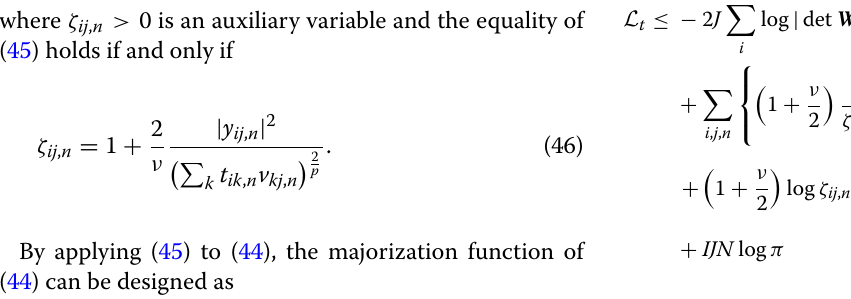
Fig. 18 Average SDR improvements of Speech 2 with E2A_1 signal using parameter tempering